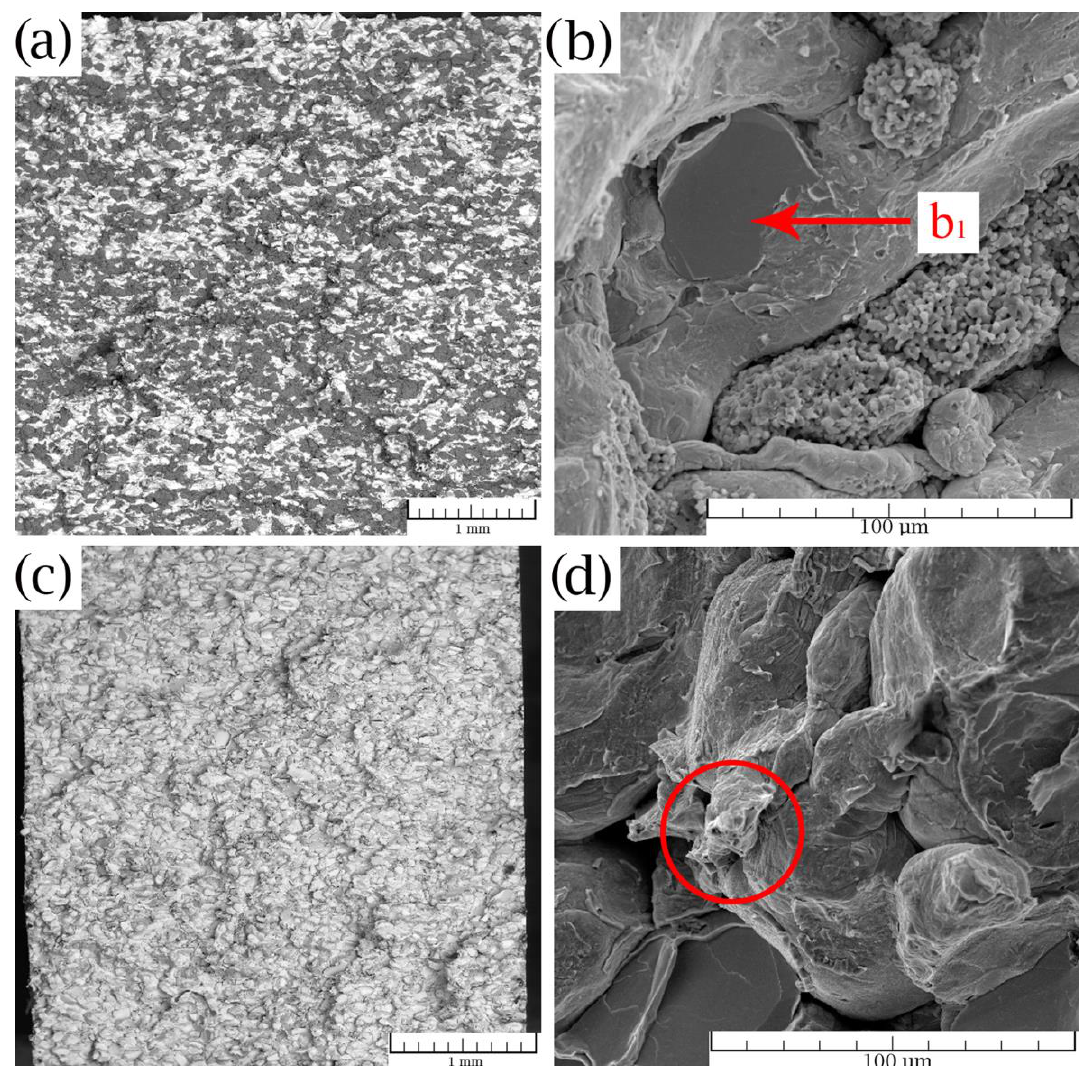
Figure 9. Fracture surfaces of ( a ), ( b ) the sintered composite Zn/HA16 with a pointed trans-granular fracture ( b1 ) and ( c ), ( d ) pure zinc with the highlighted sign of plastic deformation.